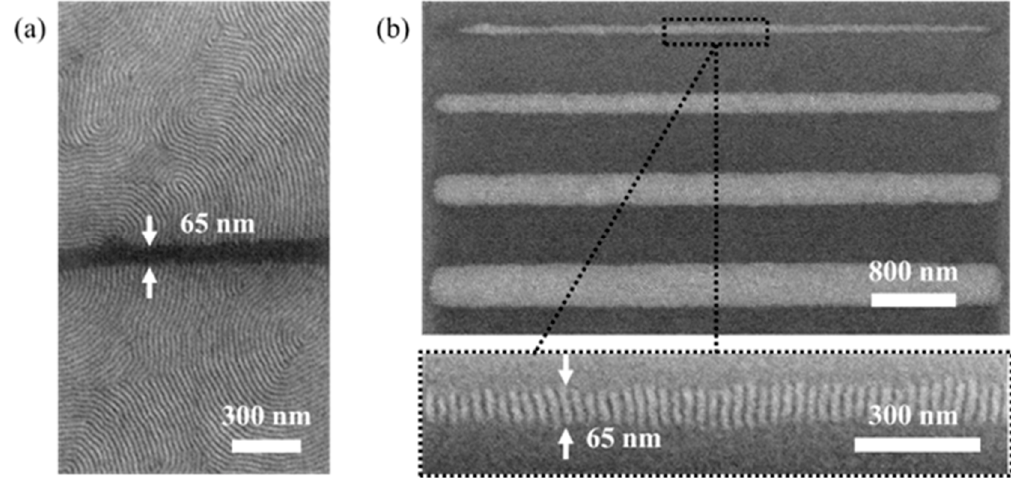
Figure 3. Results of grain-boundary-induced alignment obtained by electron beam direct writing. ( a ) Horizontal self-assembly on a 65 nm wide stripe; ( b ) vertical self-assembly (e.g., grain-boundary-induced alignment) on stripes of different widths with a minimum of 65 nm.